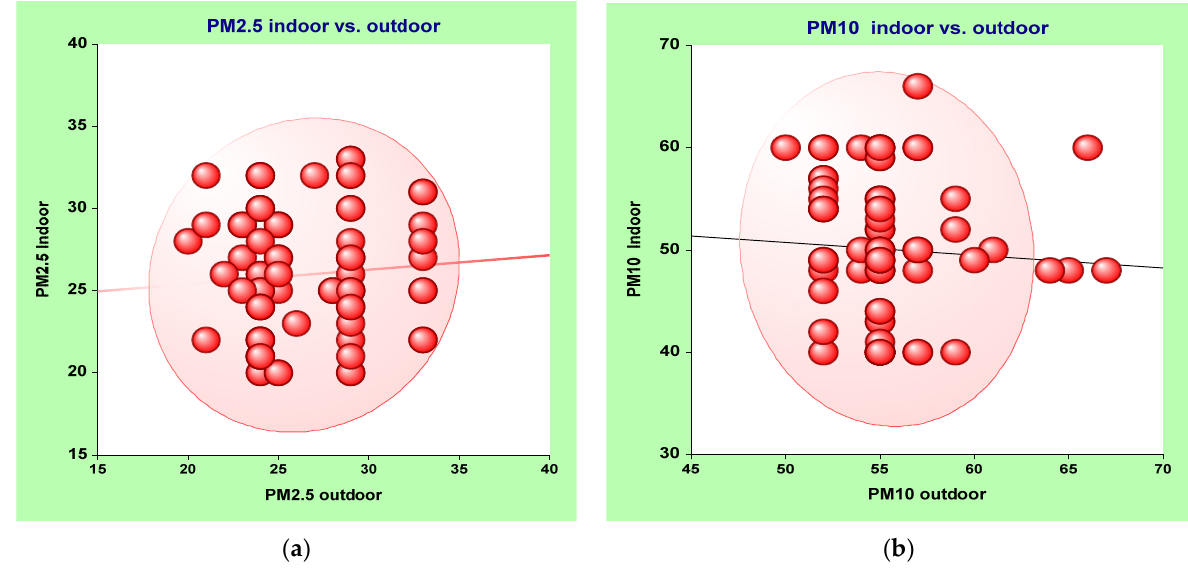
Figure 3. Correlation between indoor and outdoor ( a ) PM2.5 and ( b ) PM10.